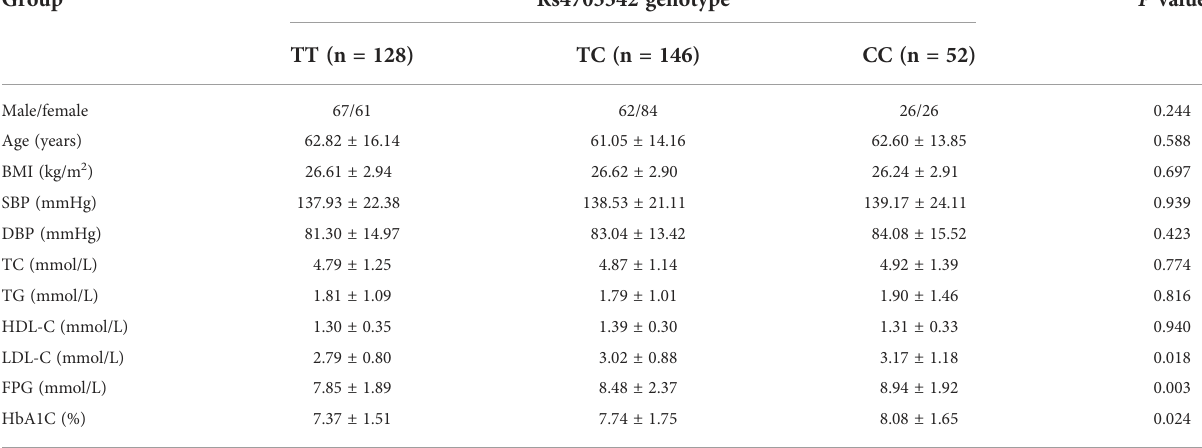
TABLE 3 Association between the rs4705342 genotypes and clinical characteristics of T2DM patients.